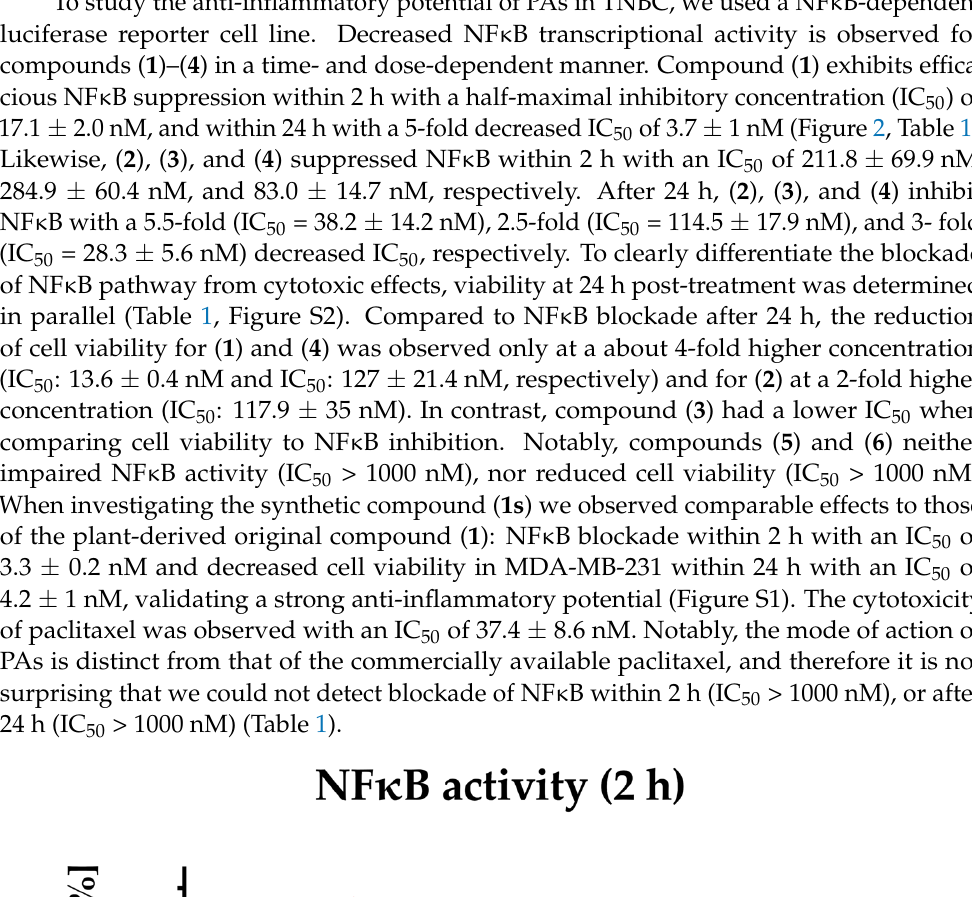
Table 1. IC 50 - values determined for NFκB inhibition and reduction of cell viability.